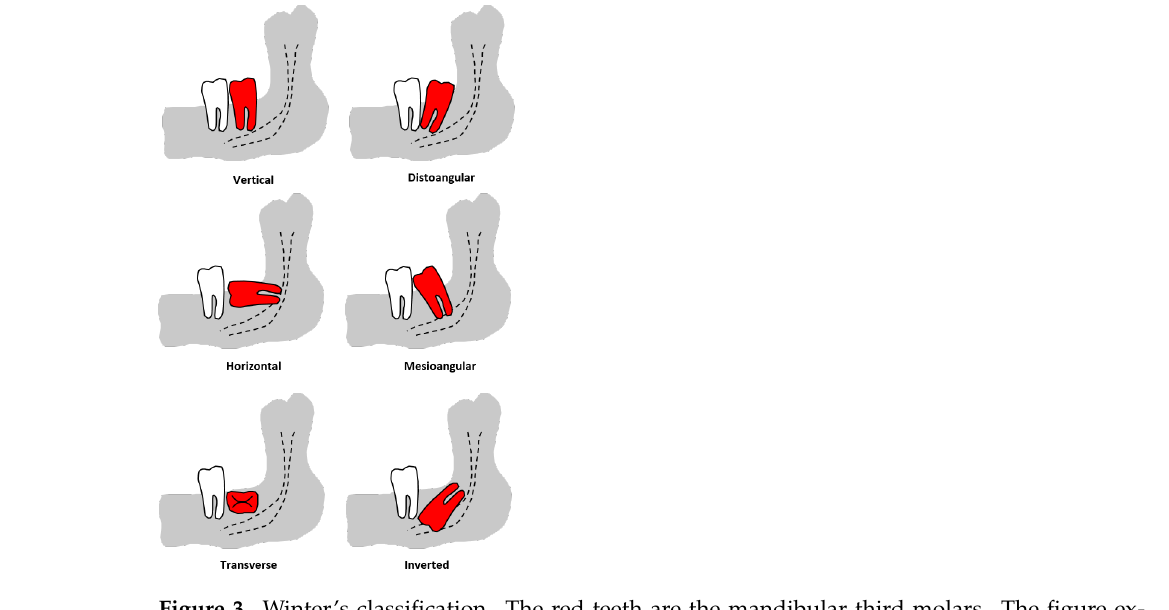
Figure 3. Winter’s classification. The red teeth are the mandibular third molars. The figure ex- pressed six types of impacted mandibular third molar according to winter’s classification: vertical, mesioangular, horizontal, distoangular, transverse, and inverted.